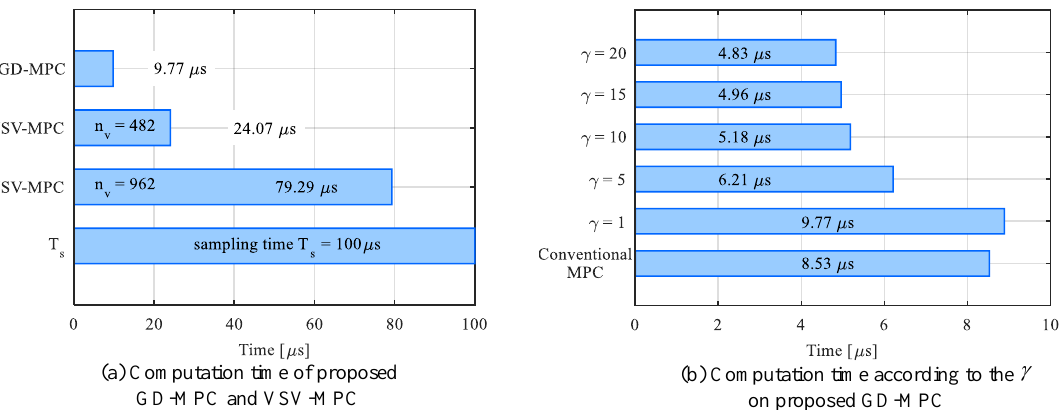
Figure 9. Computation time of the proposed gradient descent model predictive control (GD-MPC), virtual state vector model predictive control (VSV-MPC), and conventional model predictive control